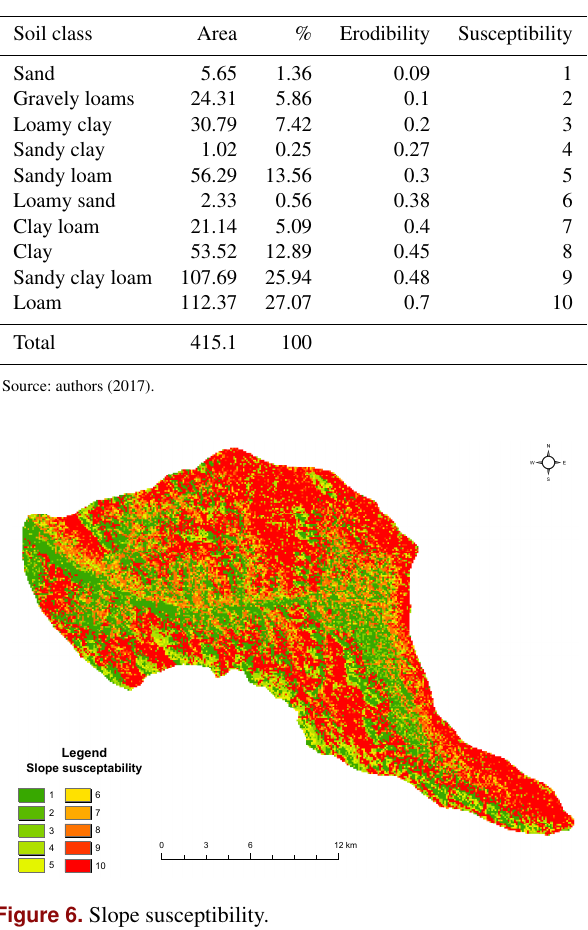
Table 5. Slope erosion susceptibility classification.